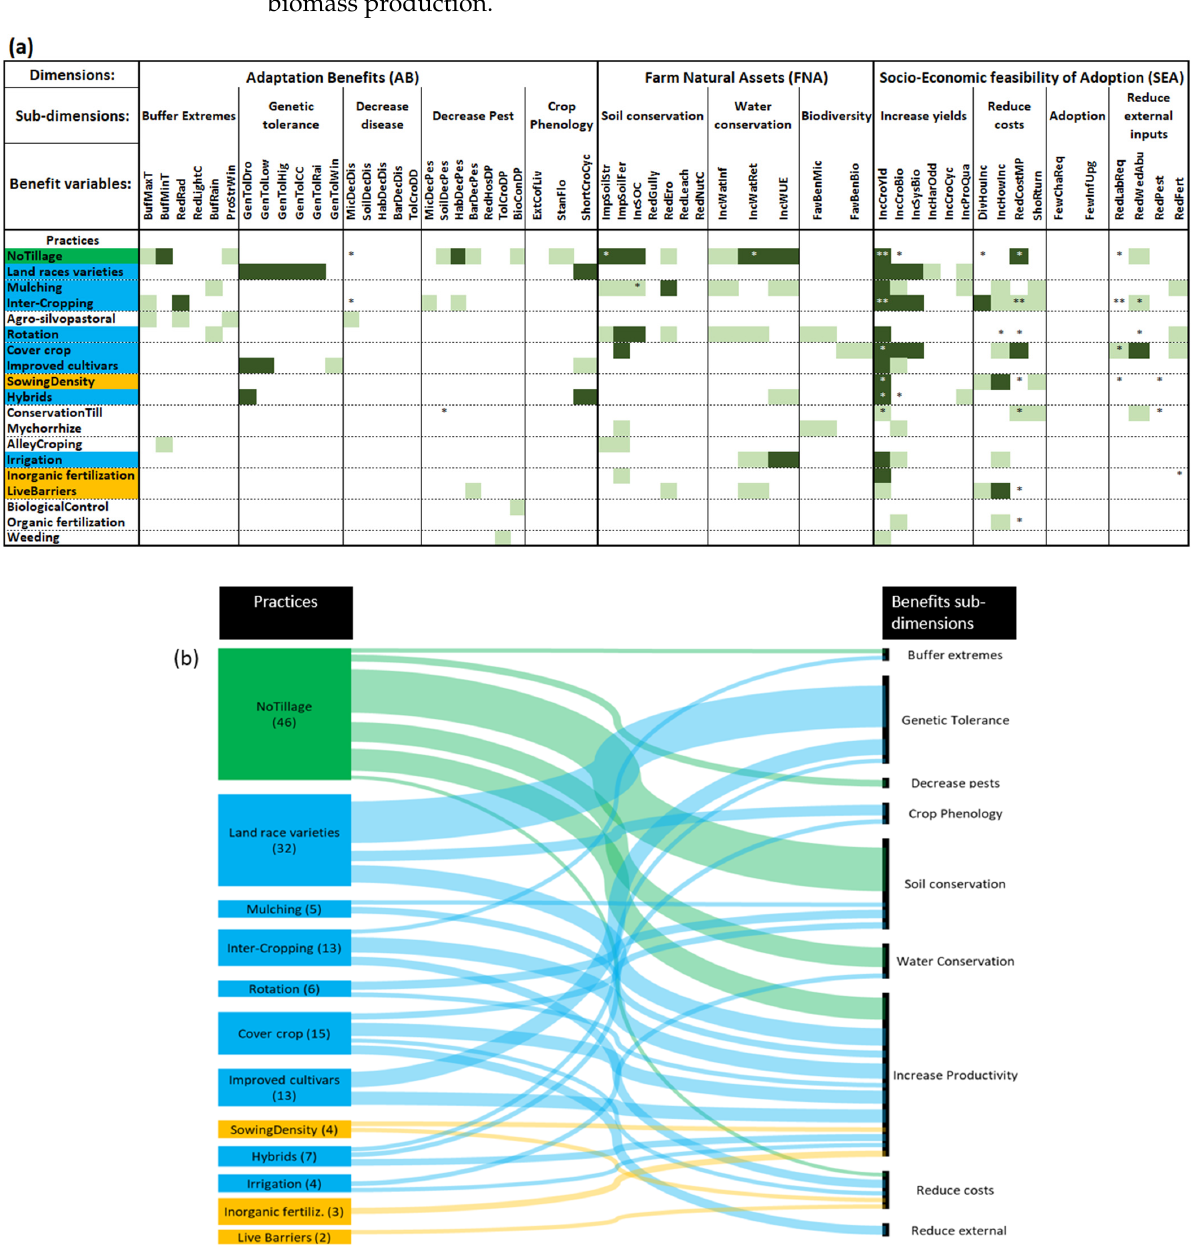
Figure 3. ( a ) Table of records ( n = 225) and knowledge gaps regarding the effects of agricultural practices (first column) on multiple benefits organized by the benefit dimensions and sub-dimensions relevant for maize smallholder adaptation. Cells in the table show where we found no record of positive effect (empty cells); only one record (light green), two or more records (darker green). For records of negative effects, the table shows only one record one (*) or two or more records (**). ( b ) Sankey evidence synthesis diagram ( n = 150) visually displays the benefits provided by those practices for which at least two or more records confirm their positive effects (i.e., darker green cells in the accompanying table).